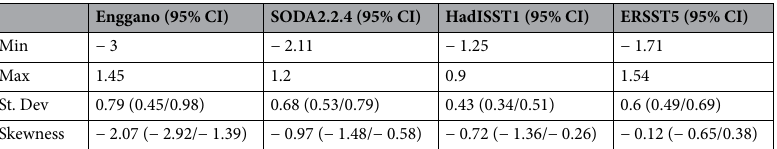
Table 2. Basic statistics of September–November mean coral SSTs and various historical SST products centered at Enggano Island (5°S, 102°E) for the time period 1930–2008. All records were centered to their mean. 95% confidence levels were calculated using bootstrap